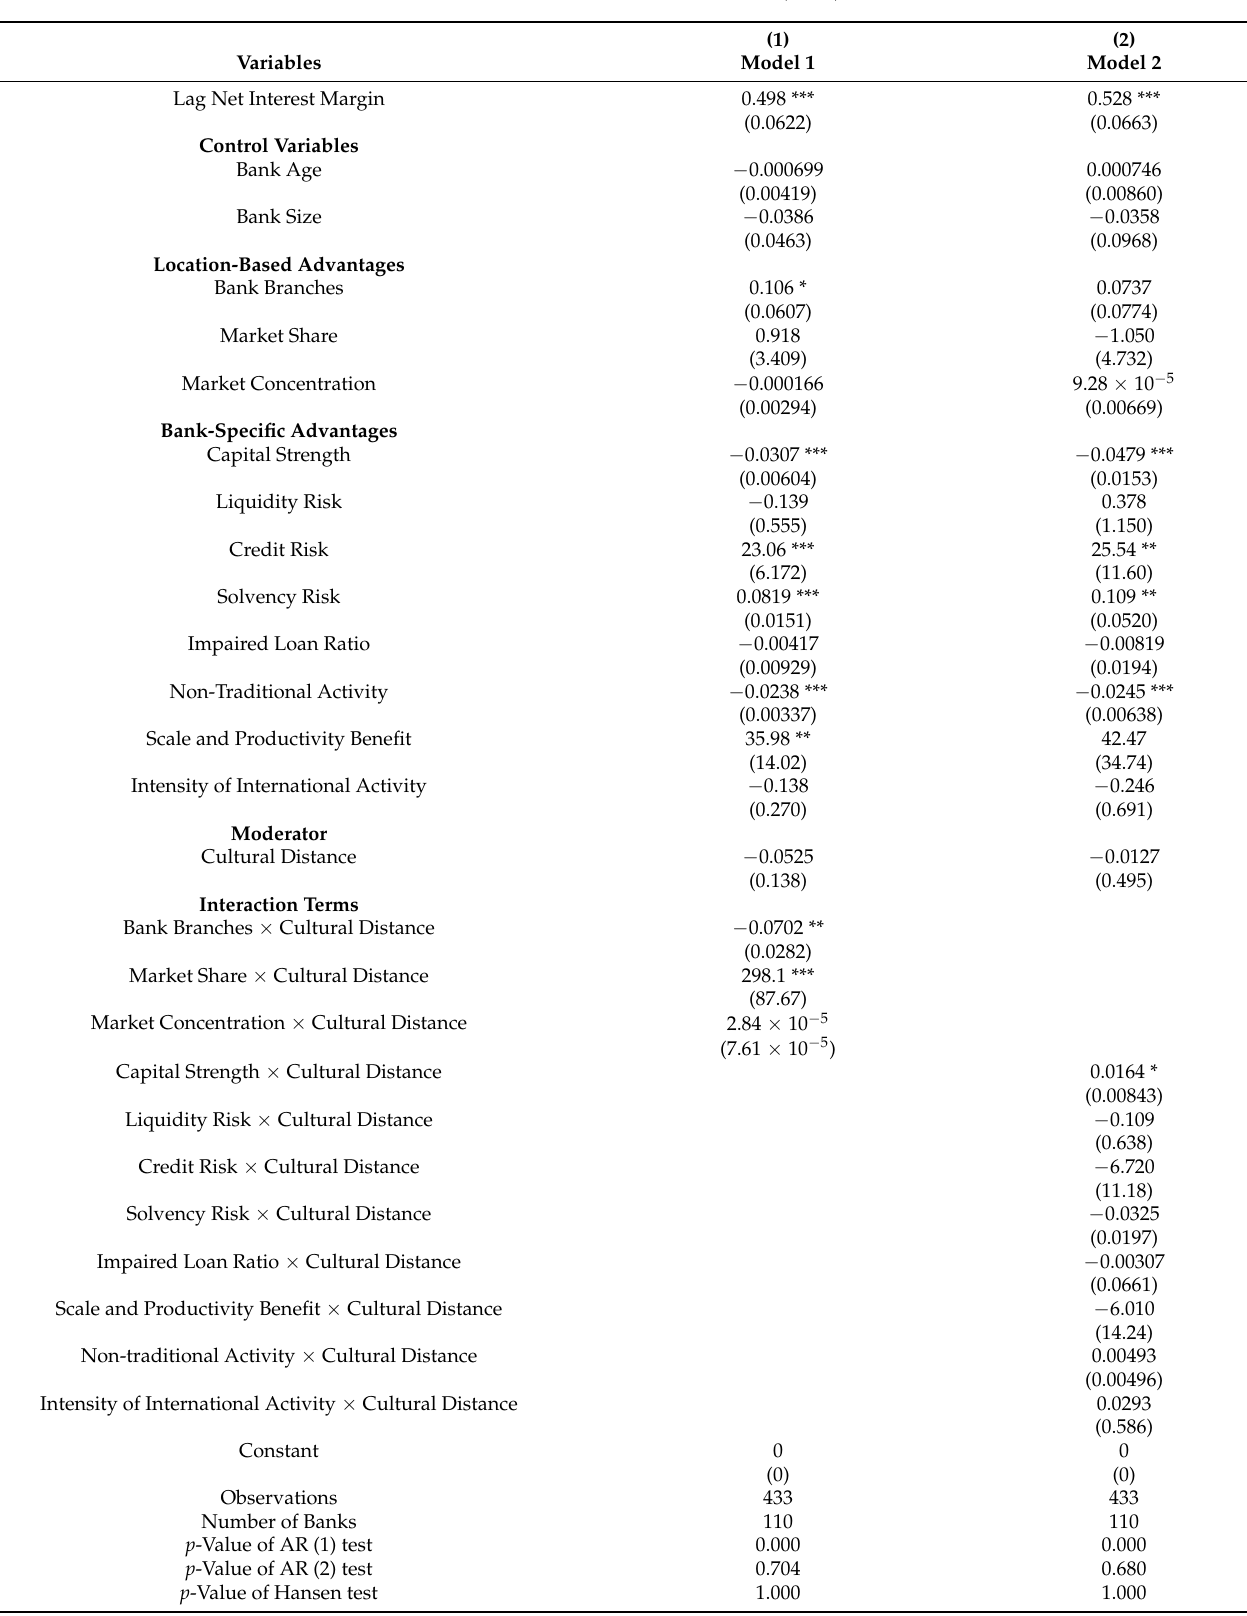
Table 9. Panel GMM model estimates